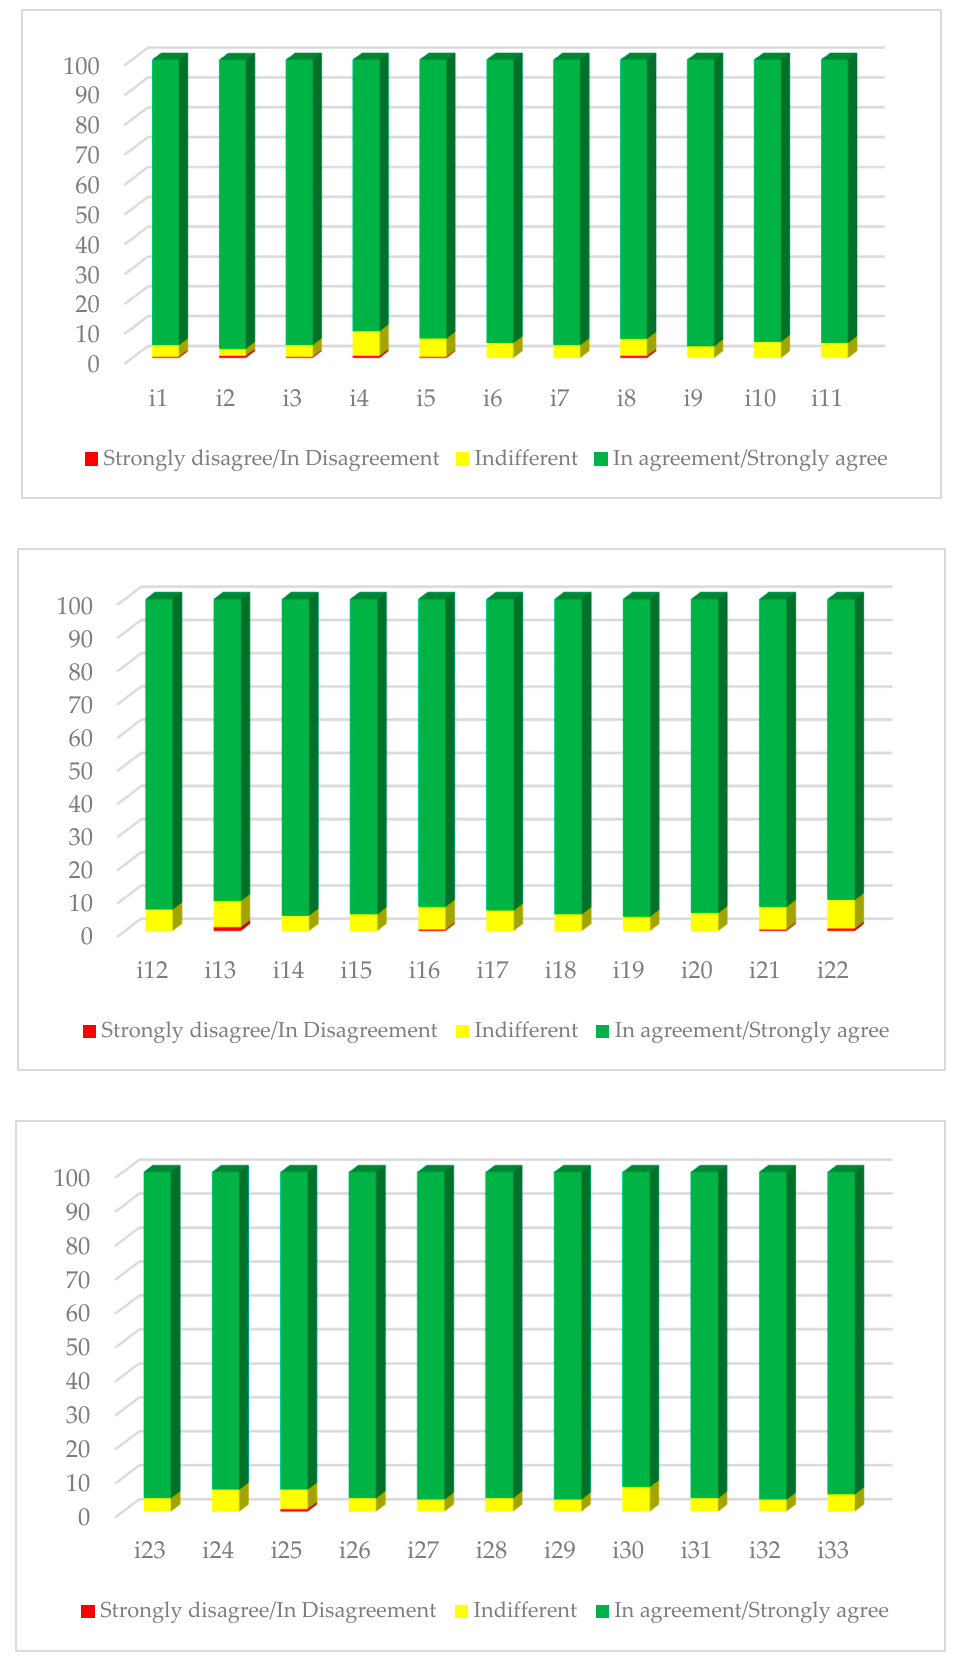
Figure 2. Response percentages for items of the clinical simulation satisfaction questionnaire.